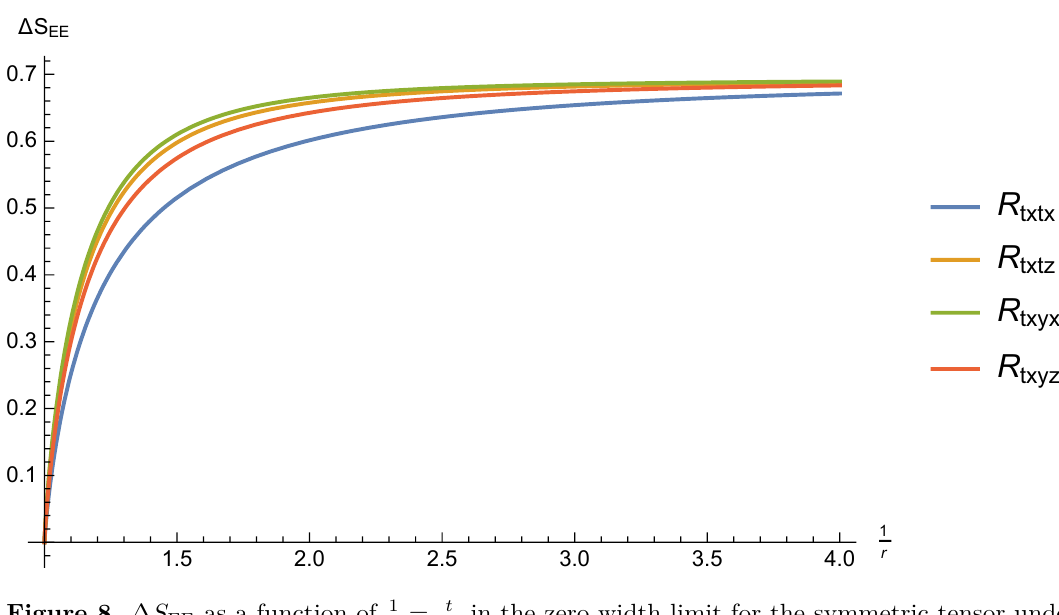
Figure 8 . ∆ S EE as a function of 1 SO(2) T × SO(2) L . Class 4, 5, 6, 7 contain all the 9 curvature components of these classes. We have plotted a representative from each of the